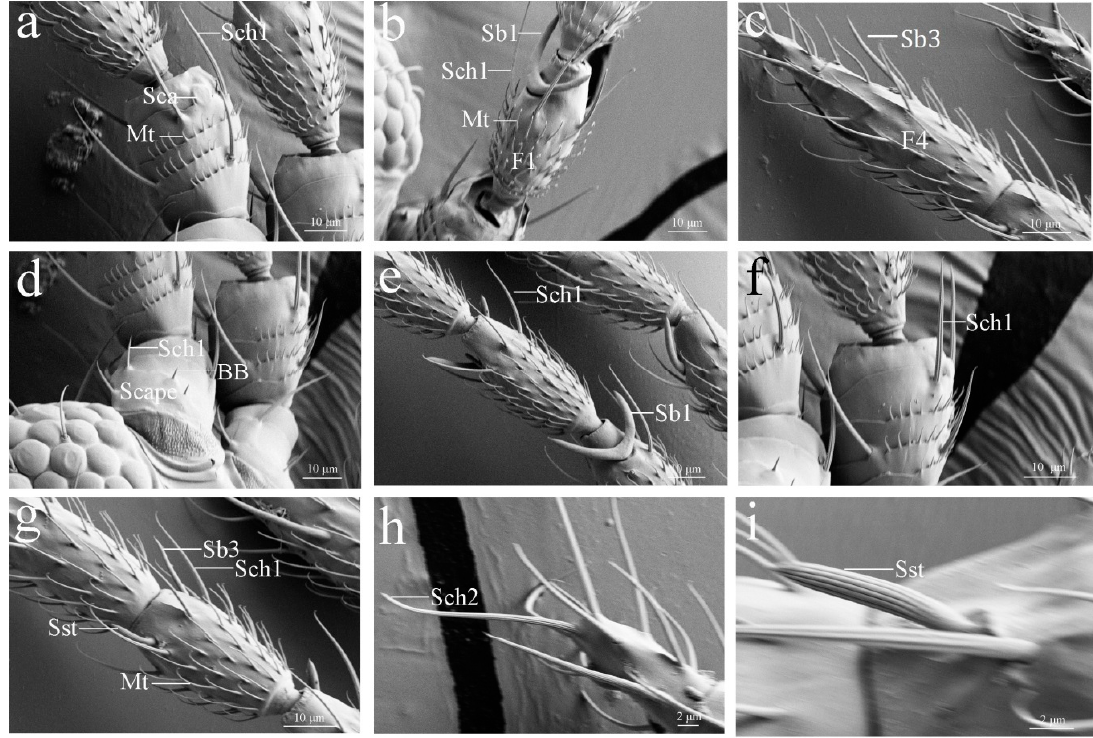
Figure 3. Scanning electron microscopy micrographs describing different features of the antennae sensilla of Thrips palmi (Karny). ( a ) Sensilla campaniformia (Sca), sensilla chaetica 1 (Sch1) and microtrichia (Mt) were found on the scape and pedicel. ( b ) Sensilla basiconica 1 (Sb1), sensilla chaetica 1 (Sch1) and microtrichia (Mt) were found on the F1 of flagellum. ( c ) Sensilla basiconica 3 (Sb3) was found on the F4 of flagellum. ( d ) Böhm bristle (BB) and sensilla chaetica 1 (Sch1) were found on the scape. ( e ) Sensilla basiconica 1 (Sb1) and sensilla chaetica 1 (Sch1) were found on the F1 and F2 of flagellum, respectively. ( f ) The morphology of sensilla chaetica 1 (Sch1). ( g ) Sensilla styloconica (Sst), sensilla basiconica 3 (Sb3) and sensilla chaetica 1 (Sch1) were found on the F3 of flagellum. ( h ) The morphology of sensilla chaetica 2 (Sch2). ( i ) The morphology of sensilla styloconica (Sst).